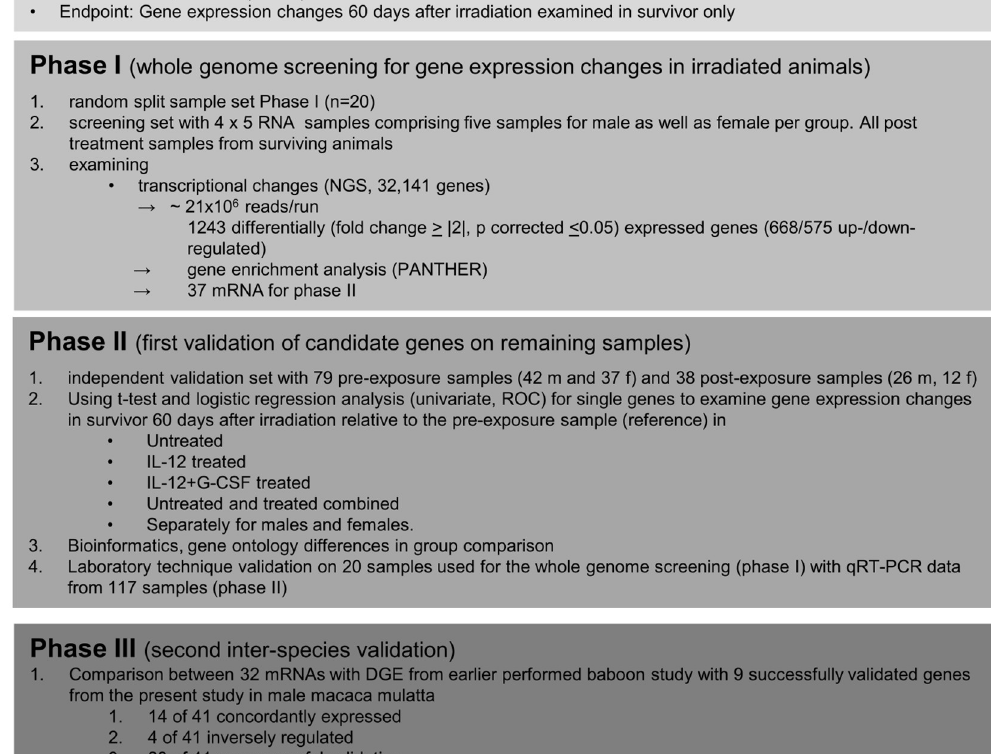
PLOS ONE | https://doi.org/10.1371/journal.pone.0254344 July 21,